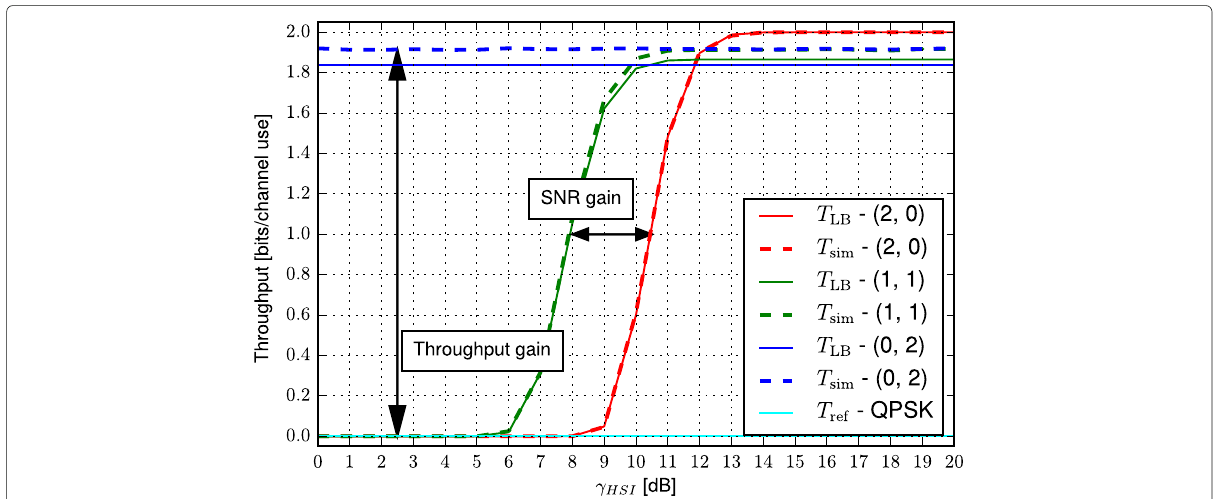
Fig. 6 Comparison of throughput as a function of γ HSI for γ MAC = 16dB, γ BC = 20dB and given ( N b , N s )